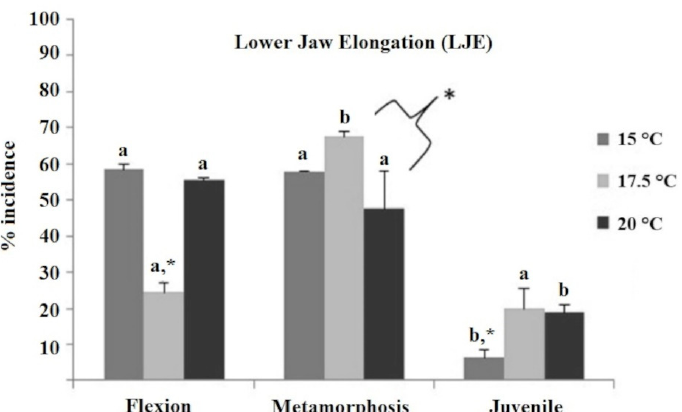
Figure 2. Incidence of lower jaw elongation (LJE) deformity (%) in European sea bass reared initially at three different temperature treatments (15 °C, 17.5 °C, and 20 °C) and evaluated at the flexion, metamorphosis, and juvenile stage. The existence of significant differences between the three temperature groups within each developmental stage (two-way ANOVA) is indicated by * (= p < 0.05). Different letters indicate significantly different means (two-way ANOVA, p < 0.05) between sampling times (flexion, metamorphosis, and juvenile) within temperature groups. Different letters denote significant differences between experimental